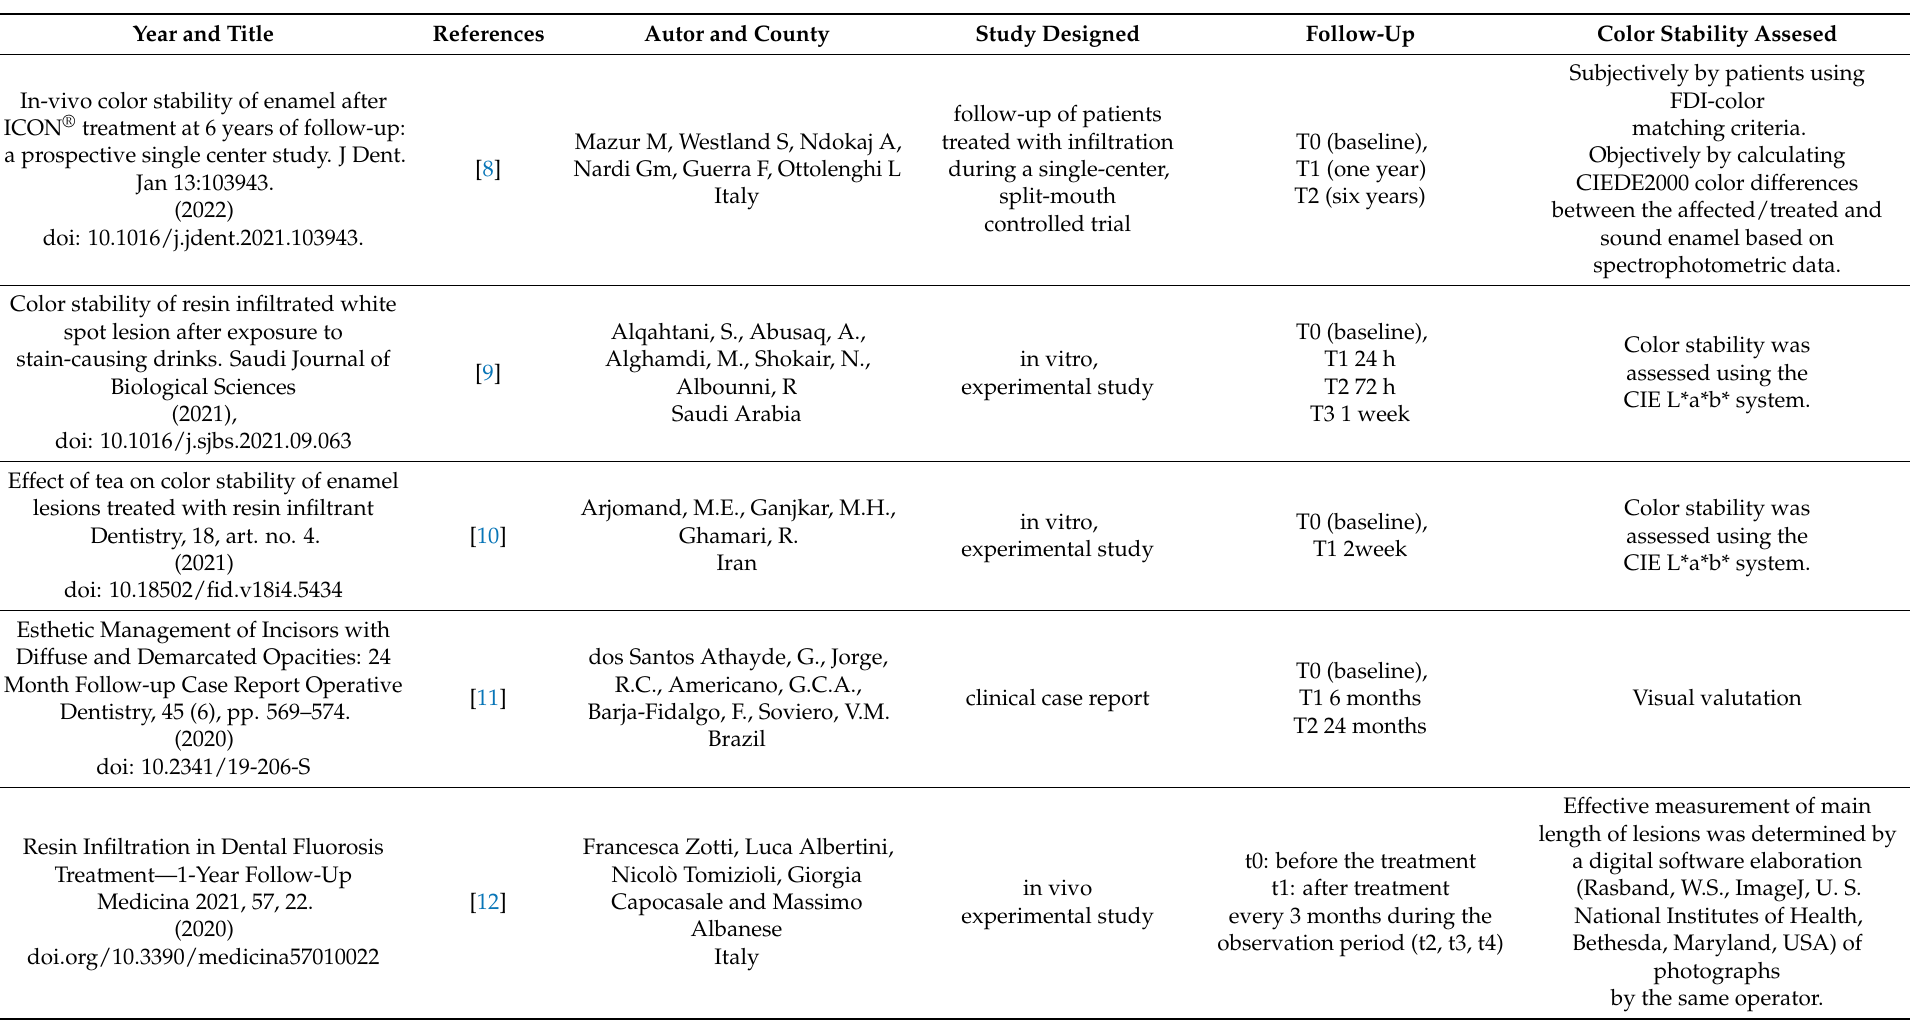
Table 3. Summary table of systematic